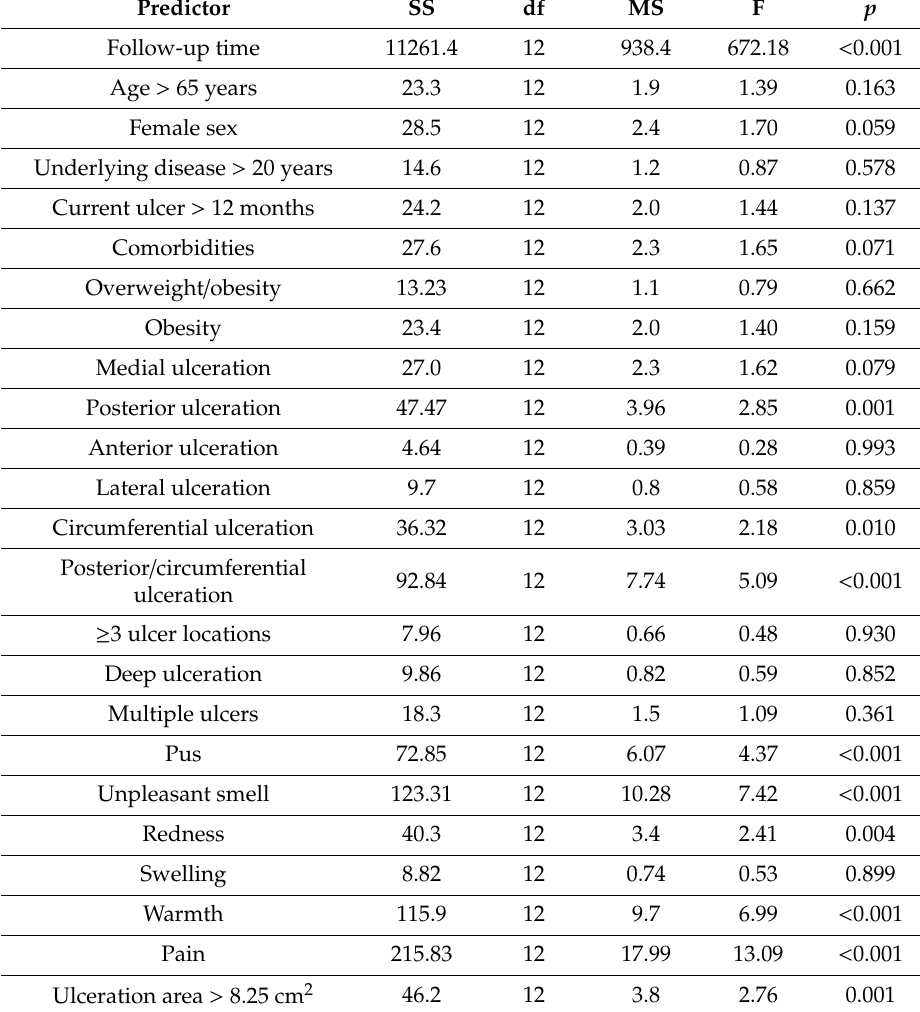
Table 3. Demographic and clinical factors as the predictors of pain severity; the results of univariate